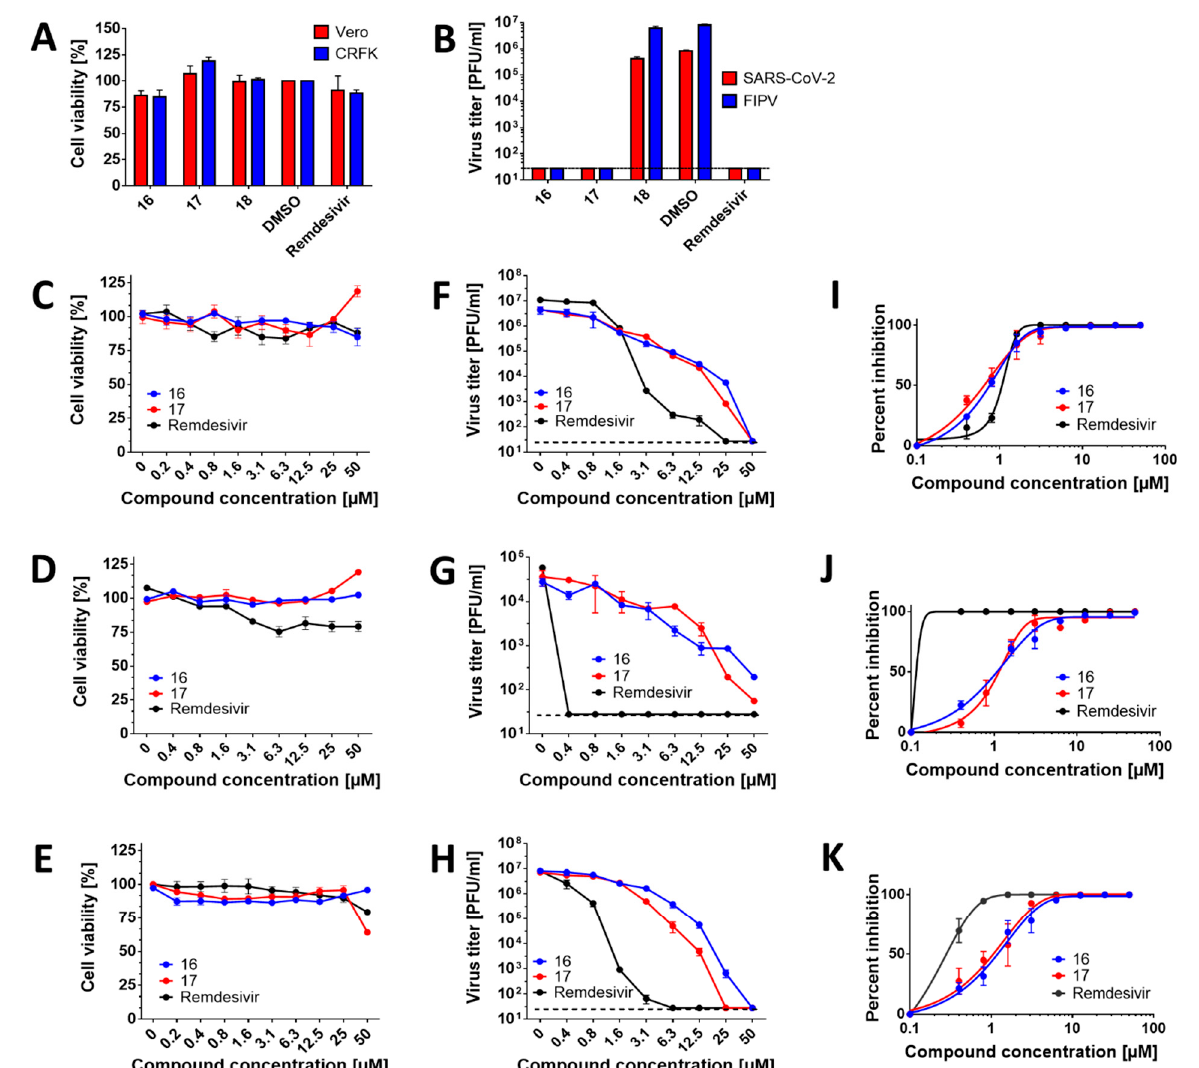
Figure 2. Antiviral efficacy and cytotoxicity of the studied RdRp inhibitors in cell-based assays. ( A ) Cytotoxicity of the indicated compounds in Vero and CRFK cells. The cell monolayers were treated with the compounds (50 µ M) and incubated for 48 h. The cell-mediated conversion of tetrazolium salt WST-8 to formazan was monitored by absorbance measurement (450 nm). Cytotoxicity was expressed in terms of cell viability percentage. ( B ) Anti-SARS-CoV-2 and anti-FIPV efficacies of the indicated compounds in Vero and CRFK cells, respectively. The cell monolayers were treated with the compounds (50 µ M), infected with the respective virus at a MOI of 0.1, and incubated for 48 h. The supernatant media were collected, and viral titers were determined by plaque assays. ( C – E ) Dose-dependent cytotoxic effects of the compounds in Vero ( C ), CaCo-2 ( D ), and CRFK ( E ) cells. The cell monolayers were treated with the compounds in the concentration range from 0 to 50 µ M and incubated for 48 h. Cytotoxicity was determined, as described for (A). ( F , G ) Dose-dependent anti-SARS-CoV-2 activity of the compounds in Vero ( F ) and CaCo-2 ( G ) cells. The cell monolayers were treated with the compounds in the concentration range 0–50 µ M and simultaneously infected with SARS-CoV-2 at a MOI of 0.1. The infected cells were incubated with the compounds for 48 h p.i., and viral titers were determined using the plaque assay. ( H ) Dose-dependent anti-FIPV activity of the compounds in CRFK cells. The protocol was the same as described for ( F , G ). ( I – K ) Inhibitory curves for the indicated compounds in Vero ( I ), CaCo-2 ( J ), and CRFK ( K ) cells. The mean titers from three biological replicates are shown, and error bars indicate standard errors of the mean ( n = 3). The horizontal dashed line indicates the minimum detectable threshold of 1.44 log 10 PFU/mL.